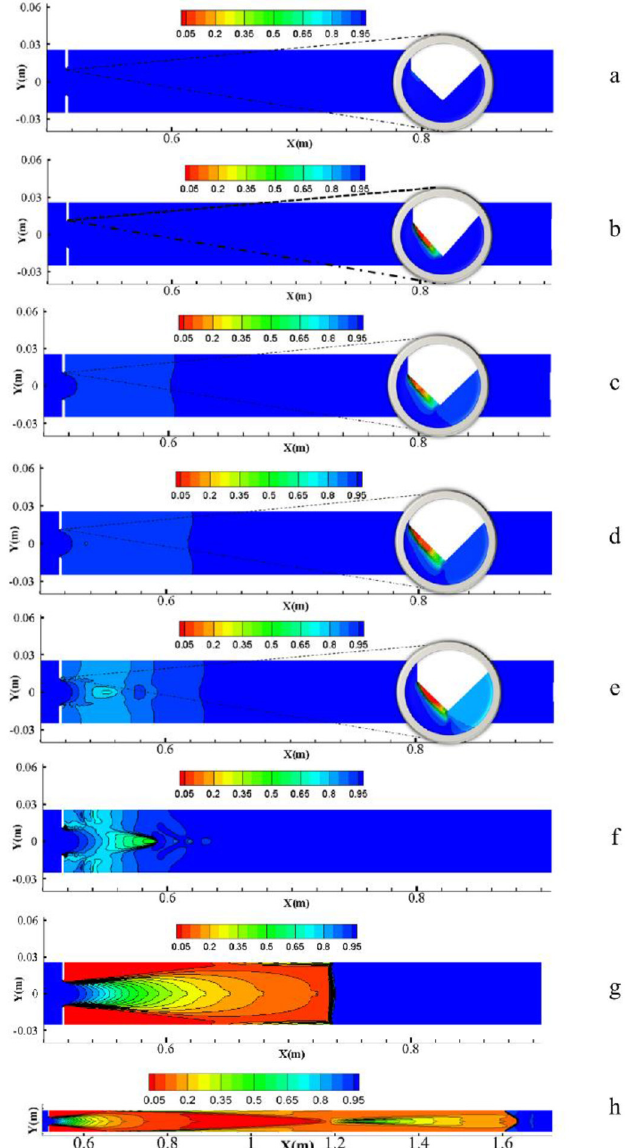
Fig. 20. The contour of cavitation volume in the ori fi ce with b =0.4 in the fl ow of (a) 14 (b) 16 (c) 18 (d) 20 (e) 22 (f) 24 (g) 26 (h) 28 m 3